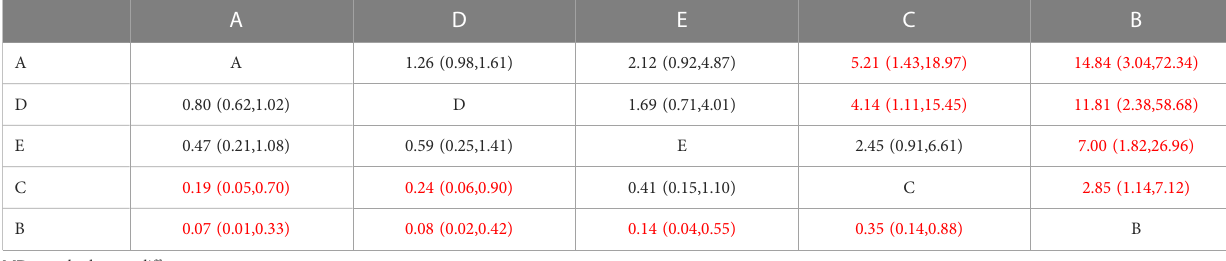
TABLE 2D Matrix of good response rate after different JAKi treatment(shown as SMD and 95% Cls).